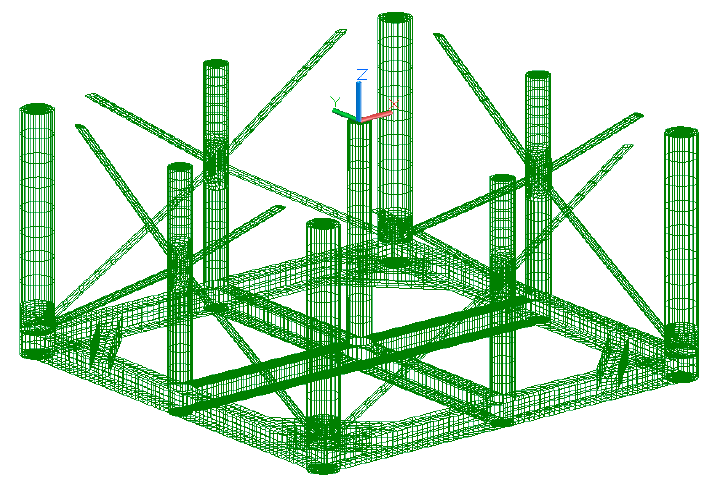
Figure 9. Wetted surface model in MultiSurf.